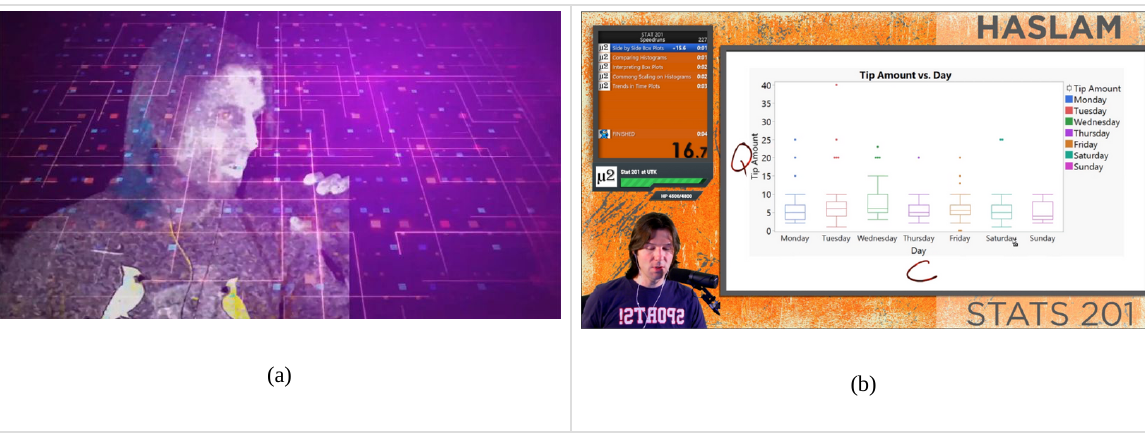
Figure 4. Screenshots of Brian Stevens’s “boss battle” (a) and “speed run” (b) segments from his online Stat 201 course at the University of Tennessee at Knoxville’s Haslam College of